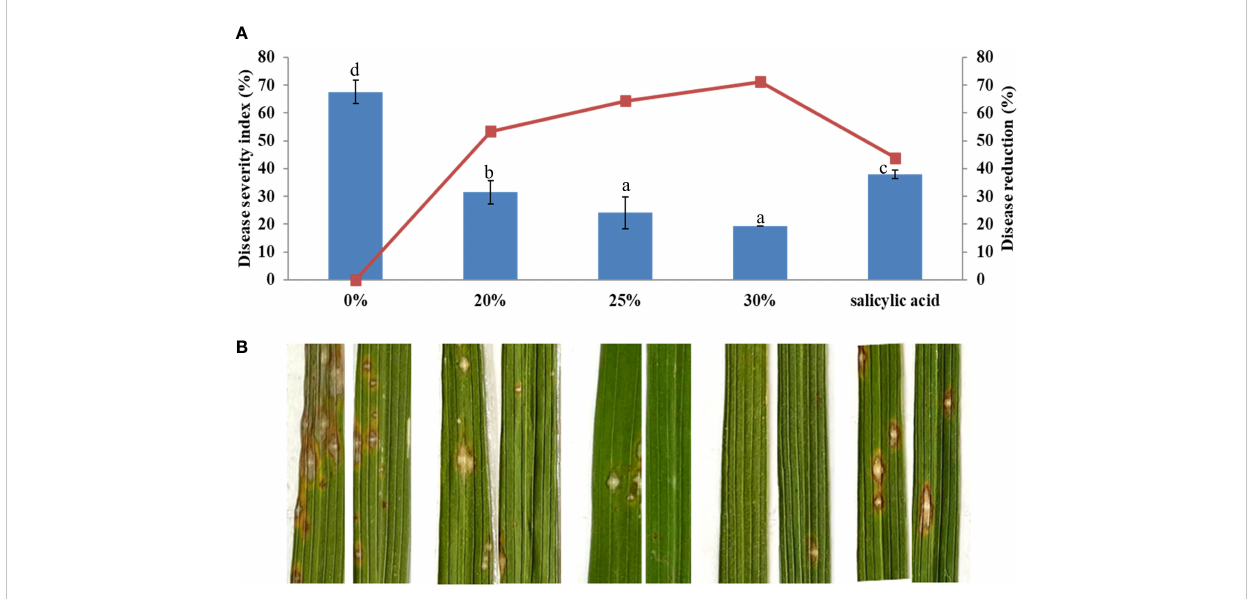
FIGURE 10 Effectiveness of the Bacillus vallismortis biosurfactant against rice blast caused by Magnaporthe oryzae in ‘ KDML 105 ’ . (A) Disease severity and disease reduction. (B) Visible symptoms on treated leaves at 21 days post-inoculation. Means in the graph followed by different letters are signi fi cantly different according to DMRT at p =